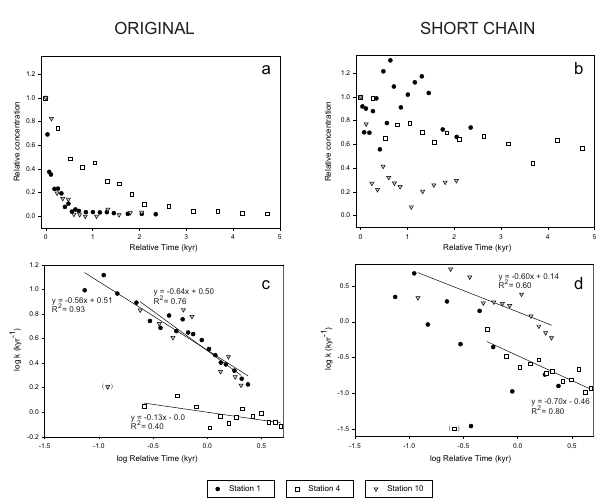
Fig. 8. Plots demonstrating the degradation of original and short chain ladderane fatty acids in three Arabian Sea sediment cores. Relative concentration (where C i = 1) versus relative time for (a) original ladderane fatty acids and (b) short chain ladderane fatty acids. Degradation was assumed to start from the depth of maxi- mum original ladderane fatty acid concentrations. Correlation plot of log k versus log relative time for (c) original ladderane fatty acids and (d) short chain ladderane fatty acids. Station 1: filled circles; Station 4: open squares; Station 10: grey